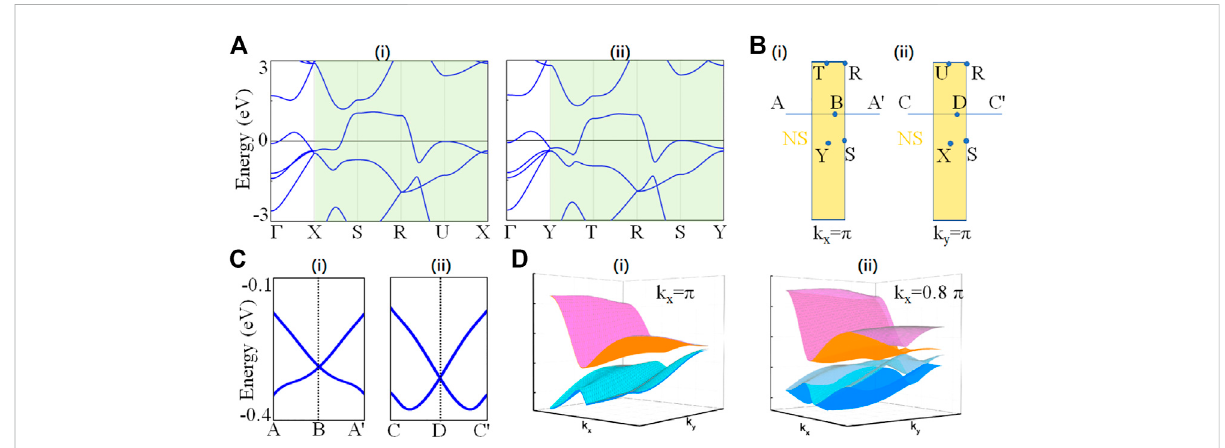
FIGURE 4 (A) Electronic band structures along k-paths (i) Y-S-R-T-Y (k x = π ) and (ii) X-S-R-U-X (k y = π ) (B) Some symmetry points of (i) k x = π /(ii) k y = π planes for LiRuO